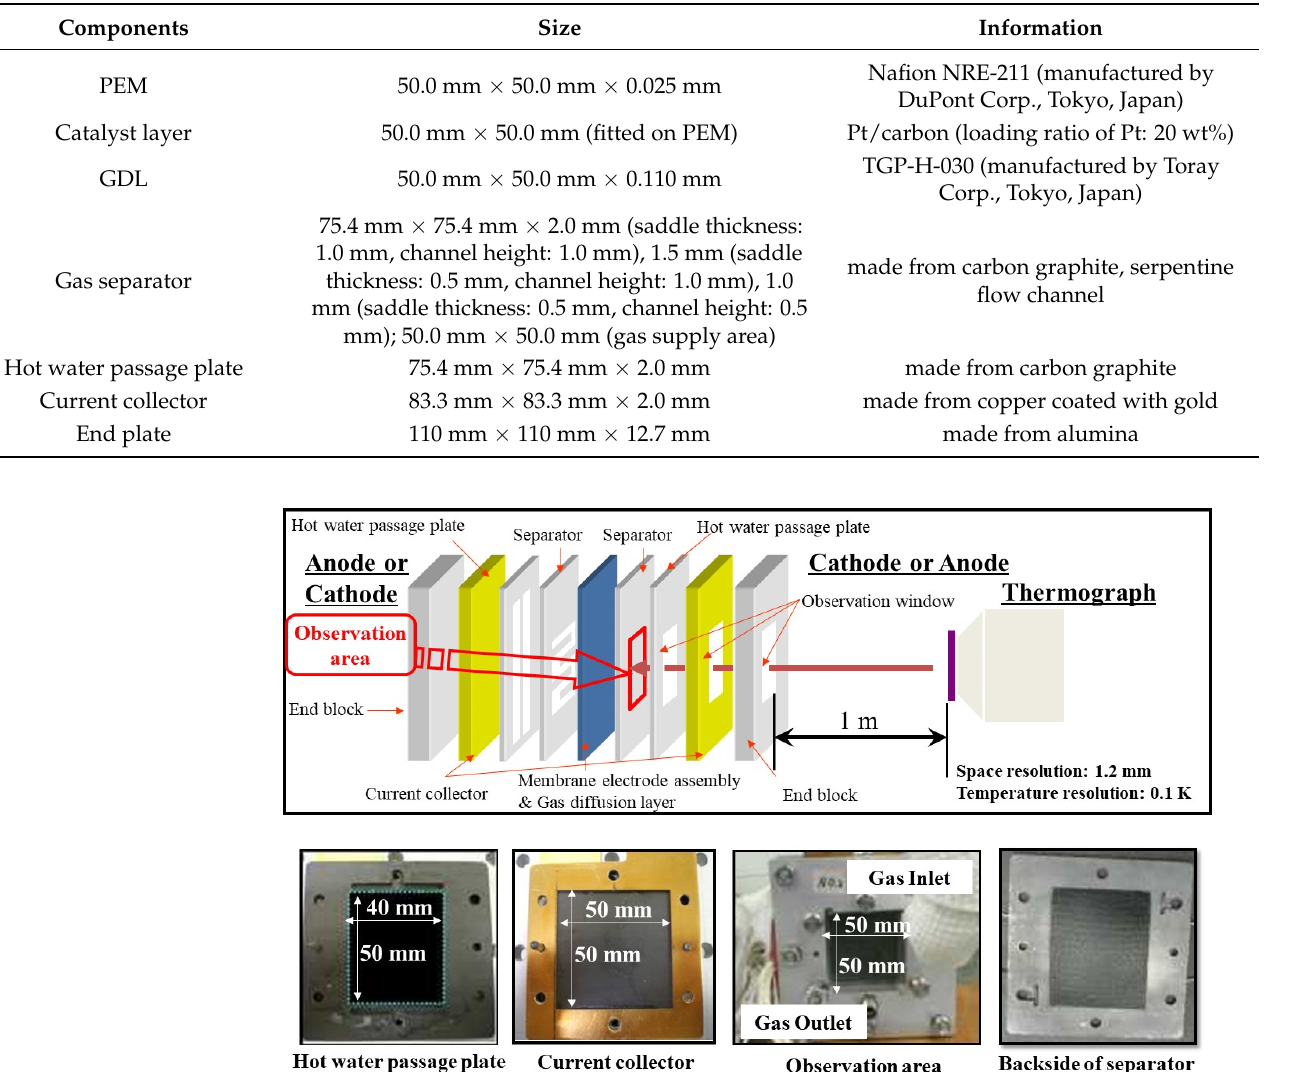
Table 1. Specifications of cell components of a single PEFC. The separator size was changed as a main parameter in this study.